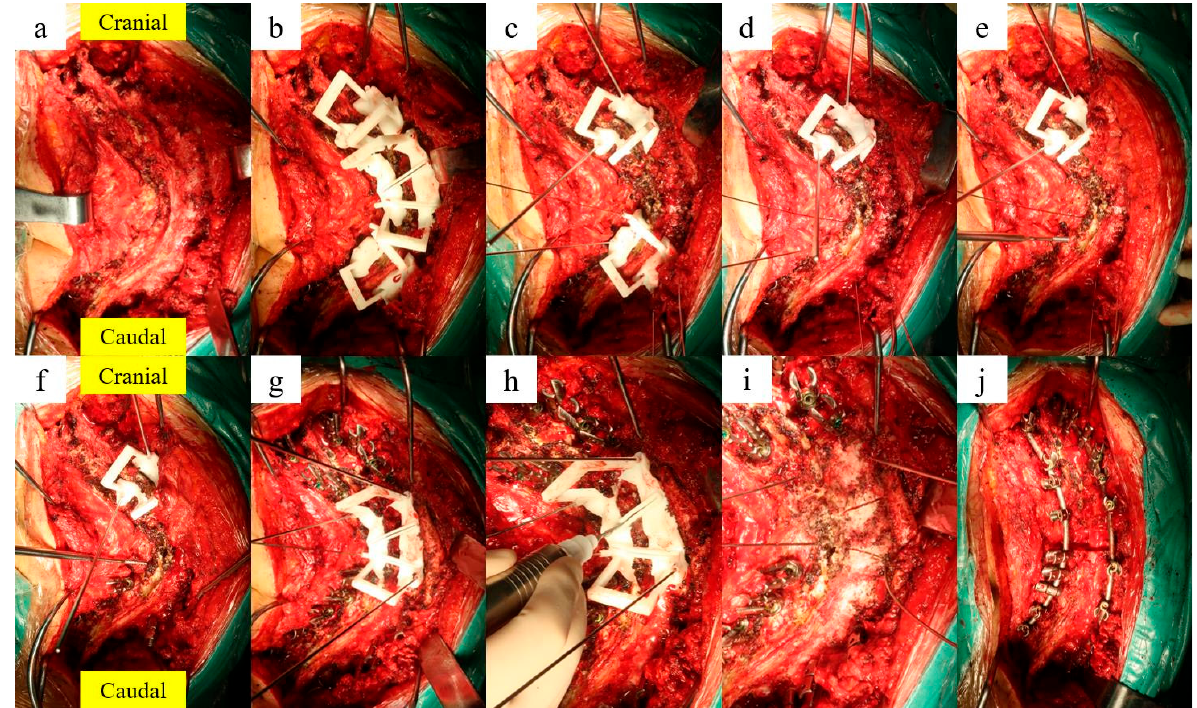
Figure 5. Surgical procedures step-by-step. ( a ) Exposure of spine; ( b ) the templates fit the spine perfectly; ( c ) insert Kirschner wires; ( d ) remove template; ( e ) drill the screw trajectory; ( f ) insert screws; ( g ) Kirschner wires help to fix the osteotomy guidance template; ( h ) performance of a VCR osteotomy using ultrasonic osteotome; ( i ) the osteotomy rails on the lamina; ( j ) complete correction of spine deformity.